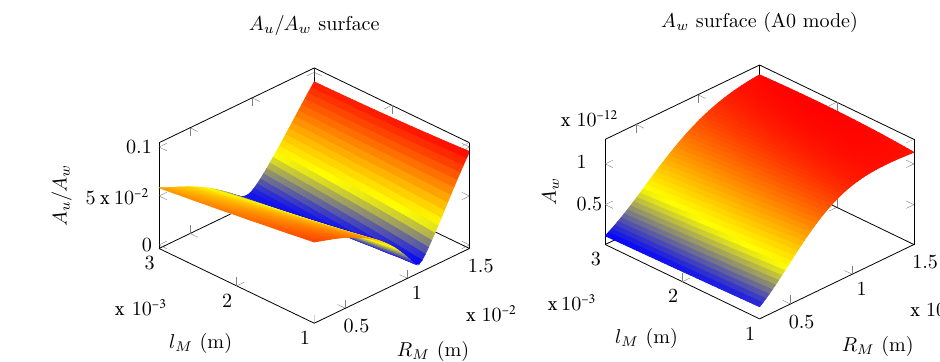
Figure 7. A u /A w and A w surfaces from multifrequency model with FFT/IFFT processing.